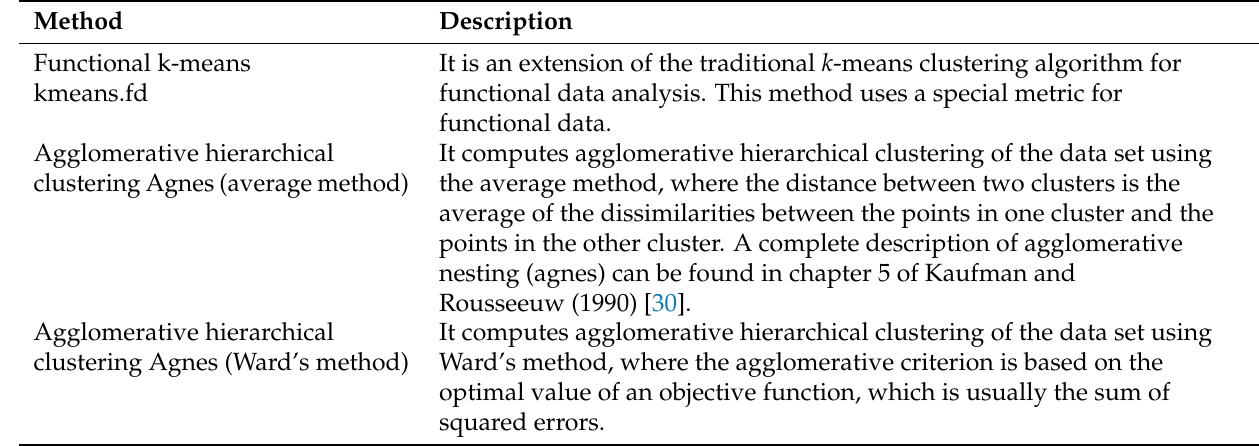
Table 1. Methods for clustering functional